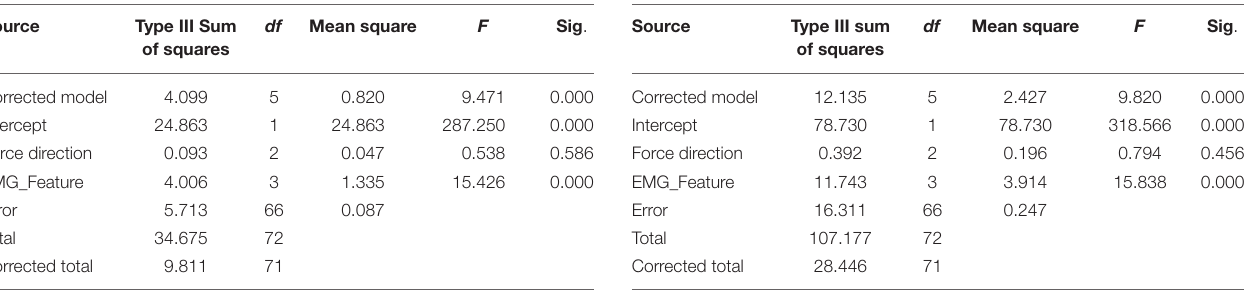
TABLE 11 | The results of the Two-way ANOVA for MAVE. TABLE 12 | The results of the Two-way ANOVA for